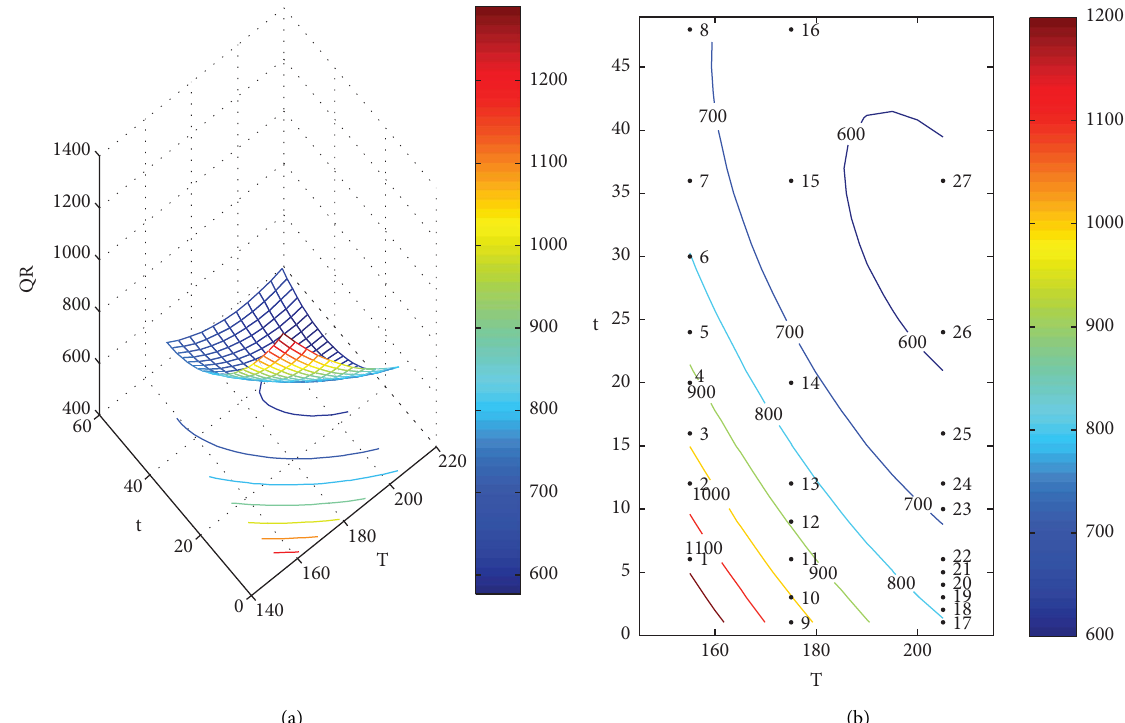
Figure 6: 3D surface graph of the regression model (a) and quality map (b) for Q heat treatment